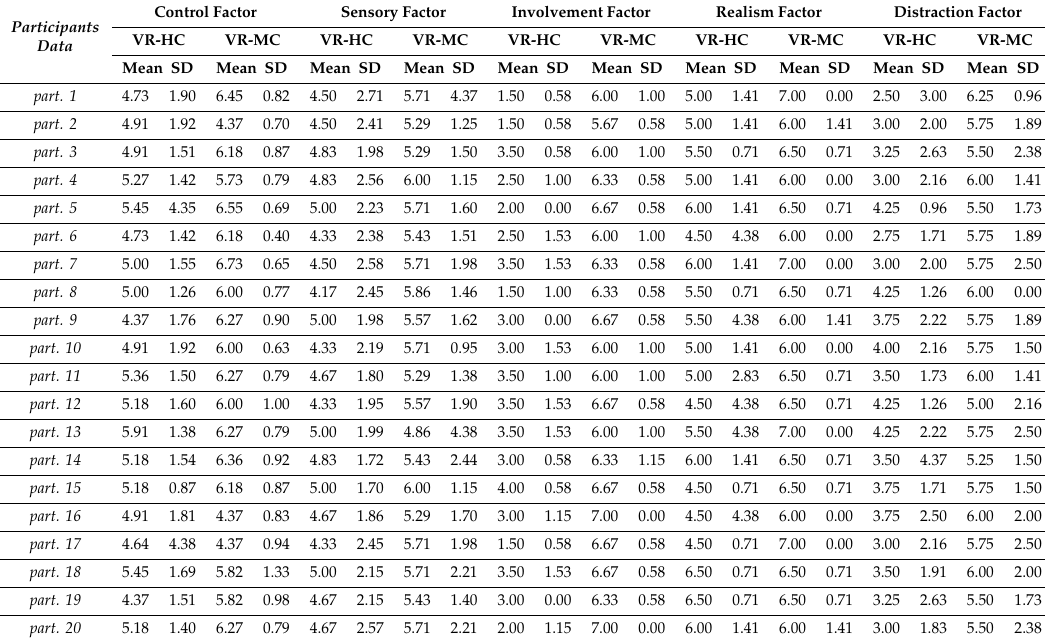
Table 1. The Mean and Standard Deviation of the Control, Sensory, Involvement, Realism, and Distraction Factors for each participant for the VR-HC and VR-MC systems.